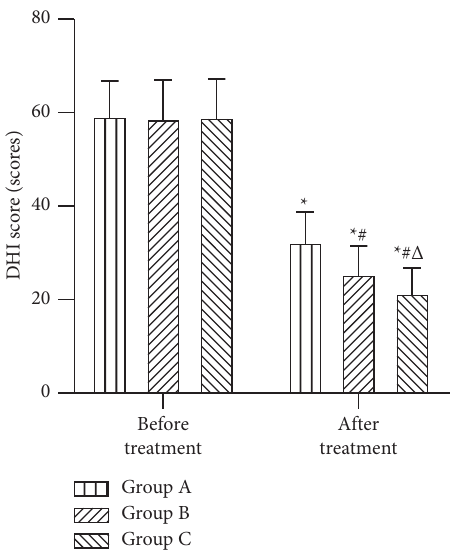
Figure 1: Comparison of 3 groups of DHI scores ( x ± s , scores). Compared with the same group before treatment, ∗ P < 0 . 05; compared with group A after treatment, # P < 0 . 05; compared with group B after treatment, Δ P < 0 . 05.